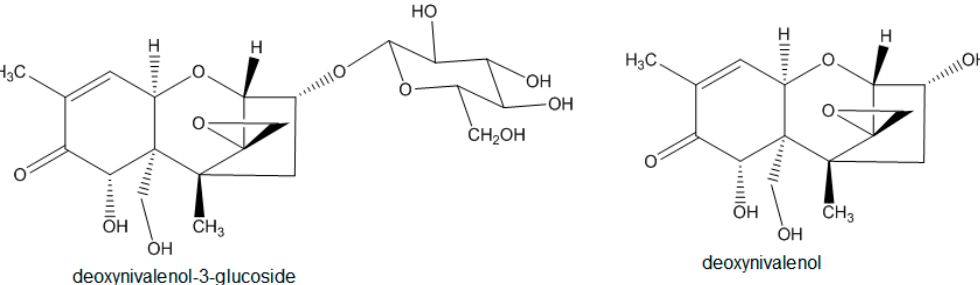
Figure 1. Structures of D3G and DON.